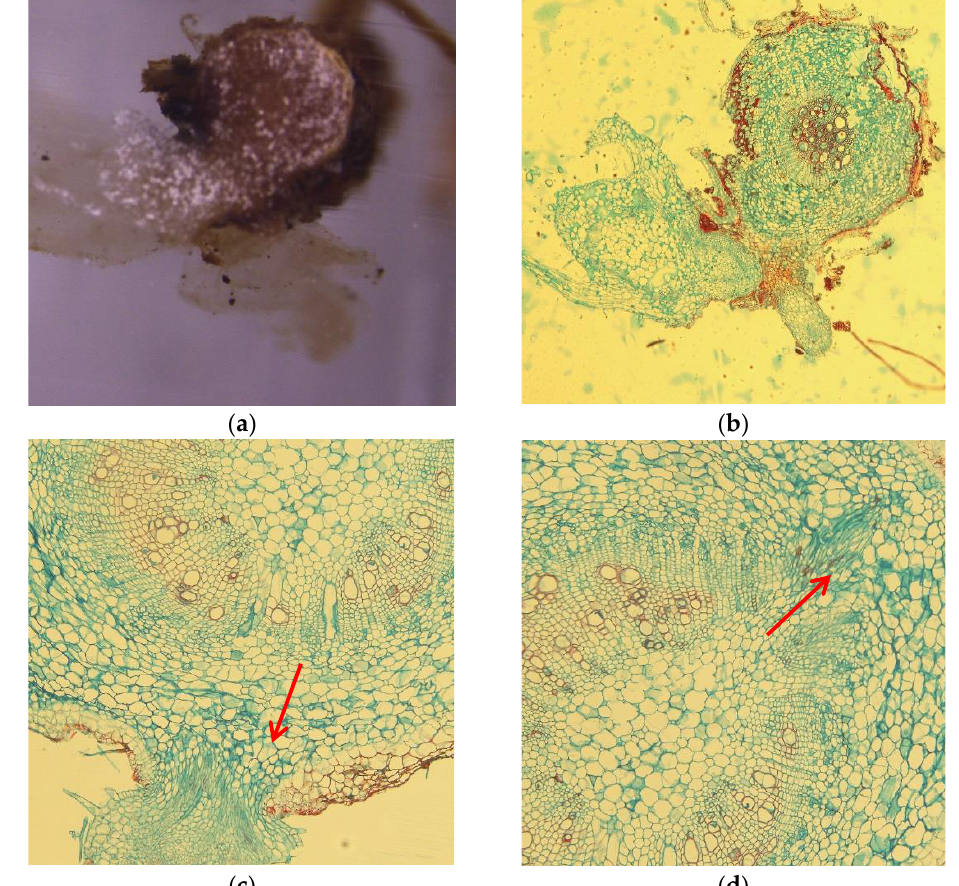
Figure 4. Observation on tissue section of Broussonetia papyrifera root propagation. ( a ) the surface of the budding part of adventitious shoot expanded; ( b ) paraffin sections of adventitious buds during budding; ( c ) formation of bud primordium, the red arrow shows the growth direction of the bud primordium; ( d ) budding of adventitious root, the red arrow shows the growth direction of the adventitious root.